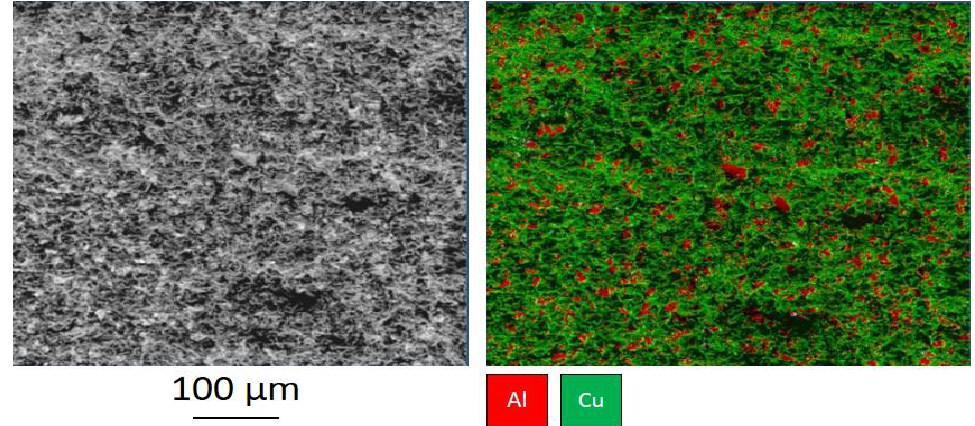
Figure 9. The microstructure and distribution maps of elements of the separation surface of the cold-